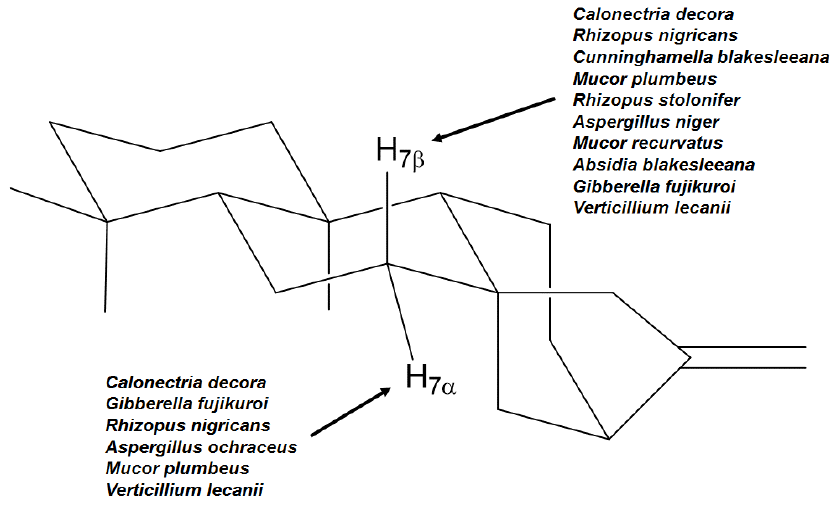
Figure 8. Examples of fungi able to carry on hydroxylation in carbon 7 of the kaurane